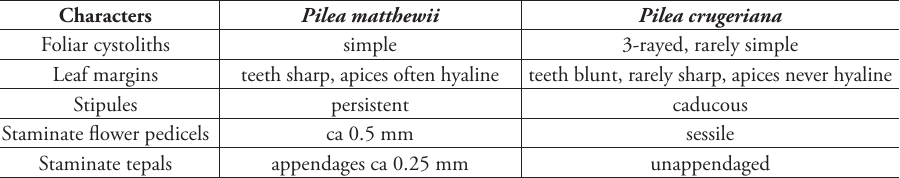
Table 1. Diagnostic characters that distinguish Pilea matthewii and P. crugeriana .